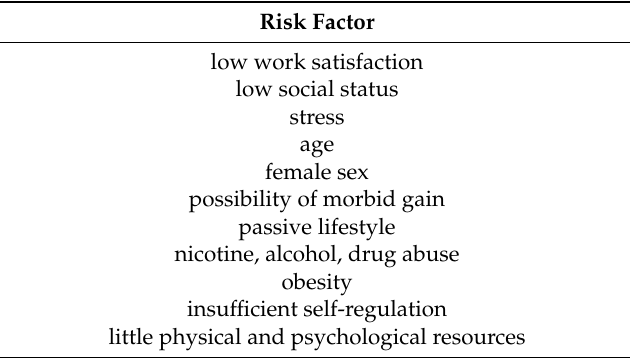
Table 2. “Yellow Flags”—risk factors of chronification of back pain